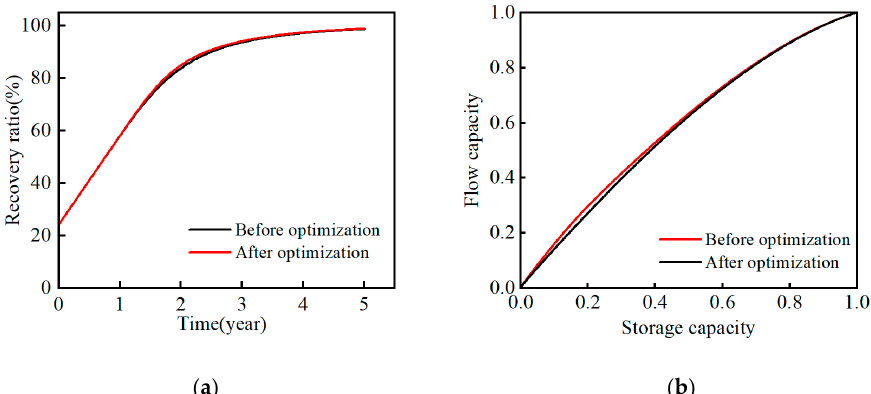
Figure 18. Flow-field adjustment of the single-layer model with a block-like permeability strip. ( a ) Recovery curve; ( b ) Lorenz curve.